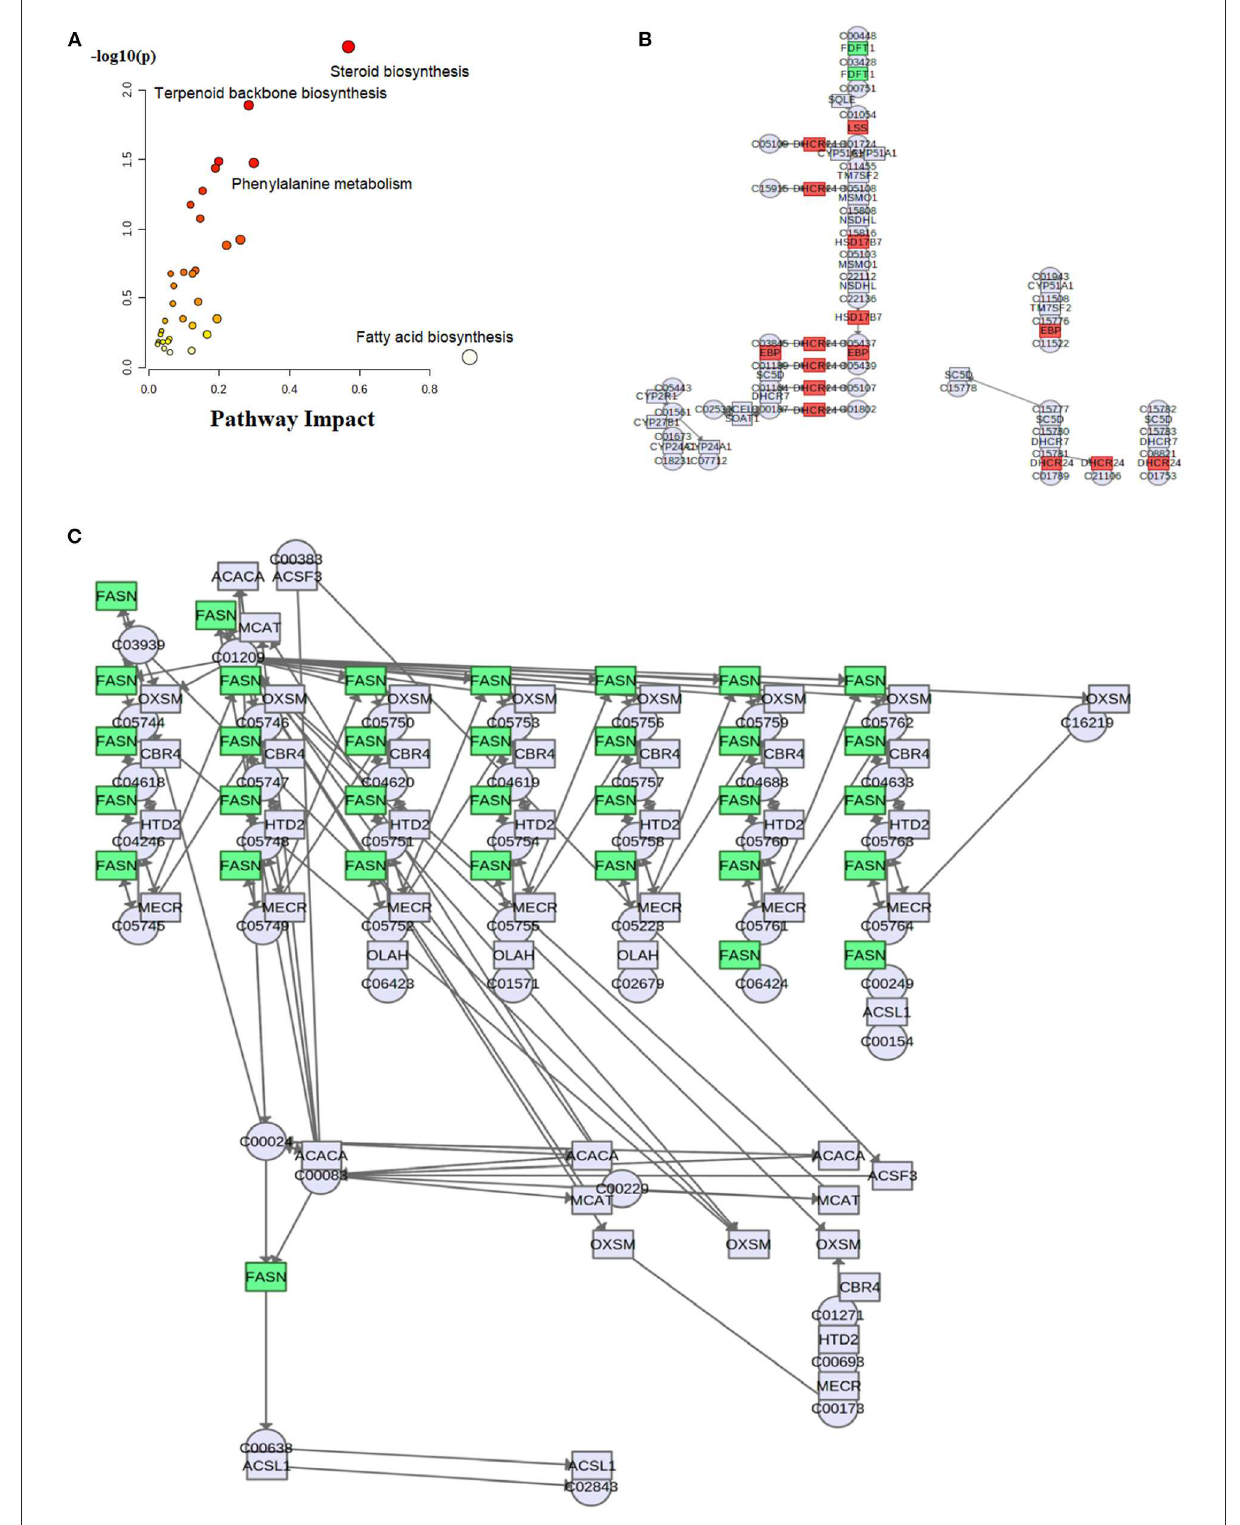
FIGURE5 Visualization of conjoint analysis between liver transcriptome and lipidome. (A) Enrichment analysis map of significant metabolic pathways; (B) steroid biosynthesis pathway; (C) fatty acid biosynthesis pathway. These results were generated from MetaboAnalyst 5.0 (https://www. metaboanalyst.ca/) Joint Pathway